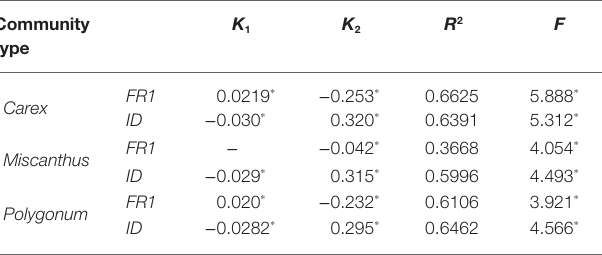
TABLE 1 | Summary of regression analysis of flood regime in the three plant communities ( Carex brevicuspis , Miscanthus sacchariflorus, and Polygonum hydropiper ) during